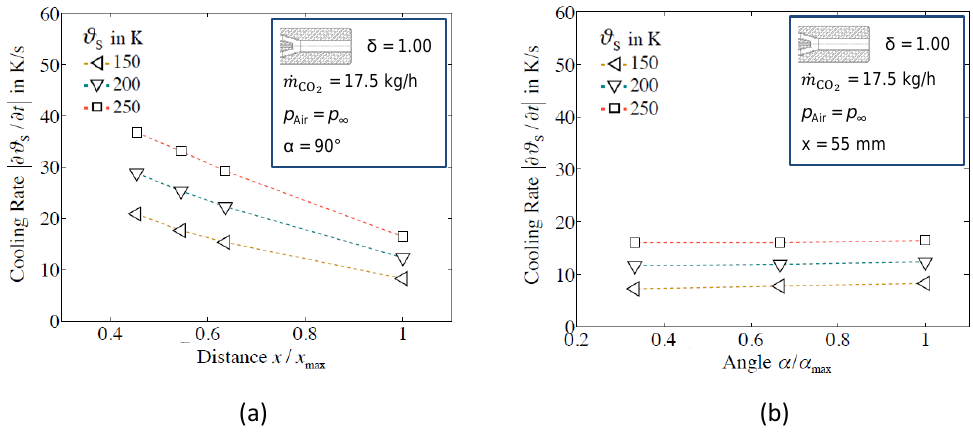
Figure 3. Influence of nozzle distance ( a ) and angular position of the nozzle ( b ) on the cooling rate.